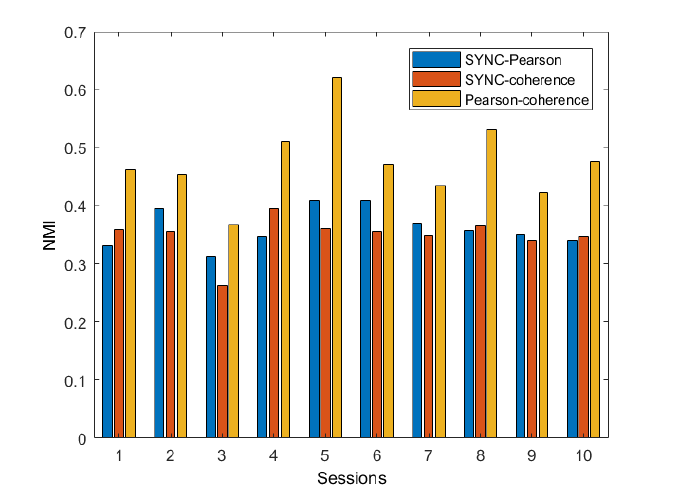
Figure 4. Error bars (mean and std) of modularity index Q over the 1000 iterations of the algorithm for the optimum resolution value γ = 1 for the three functional networks for all the sessions.